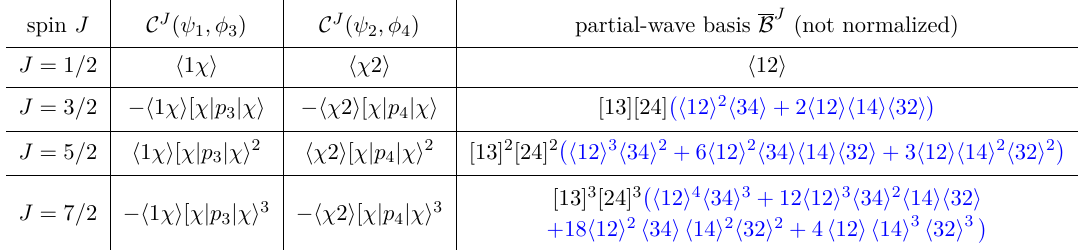
Table 3 . Partial-wave basis of process M ( ψ 1 , φ 3 | ψ 2 , φ 4 ) is an auxiliary massive spinor associated with the total momentum P = p